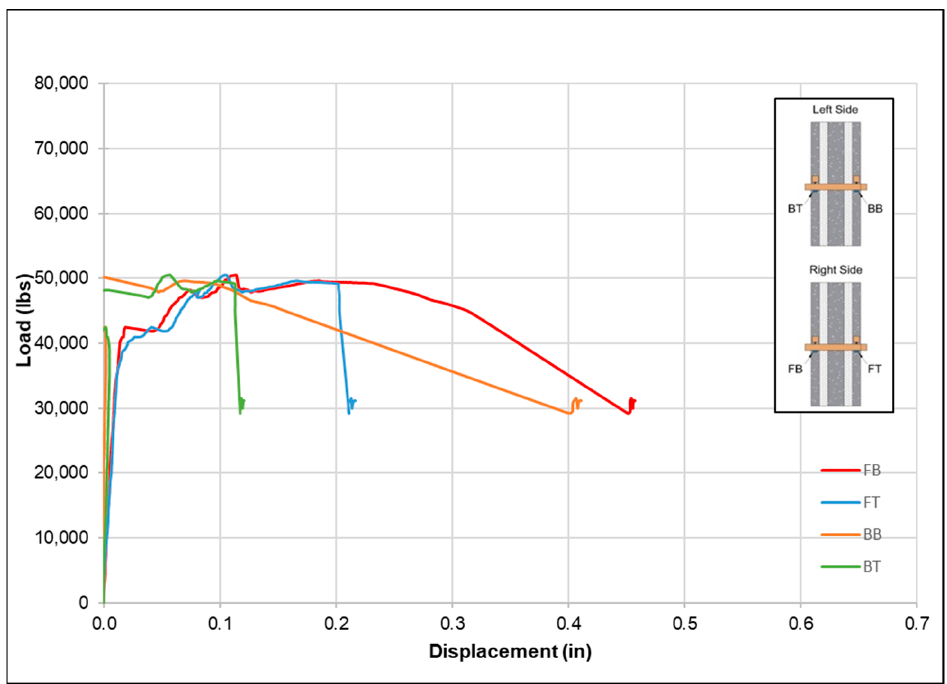
Figure 14. Load vs. displacement data from the four sensors for EPS.24.4.MMGRID.3.